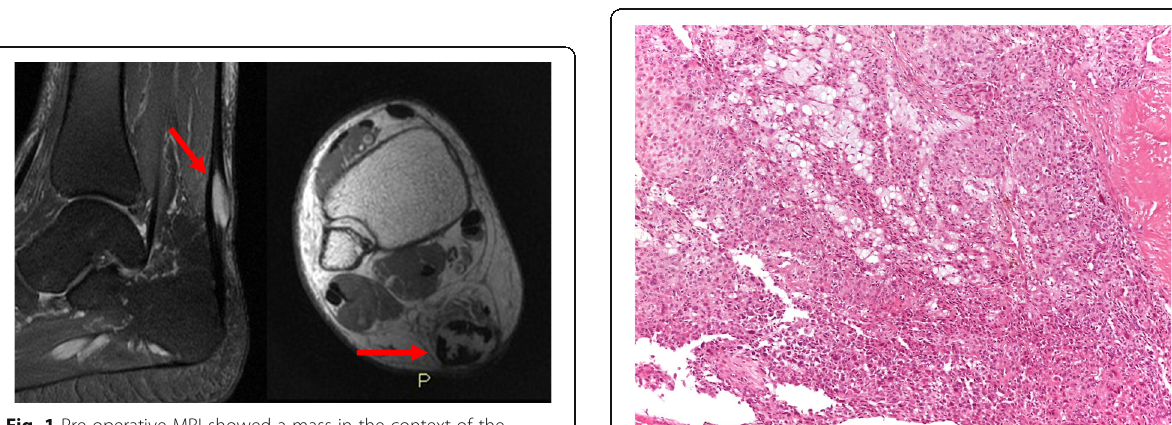
Fig. 1 Pre-operative MRI showed a mass in the context of the middle third of Achilles tendon, with hyperintense signal in T2- weighted and T2-weighted fat-sat images